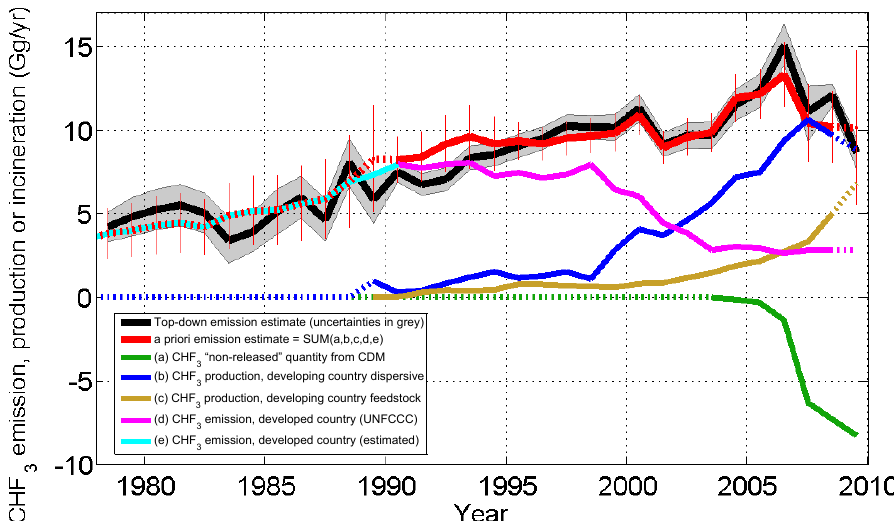
Fig. 5. Global HFC-23 (CHF 3 ) emissions from a “top-down” method (black line, 68% uncertainties shaded gray), which are based on inversion of atmospheric observations using the 2-D 12-box model, compared to the a priori emission estimate (red line, both dotted and solid, with ± 1- σ uncertainties). The a priori represents the sum of the contributions from developed and developing countries, as compiled from data submitted to the United Nations Framework Convention on Climate Change (UNFCCC) and the Clean Development Mechanism (CDM), and calculated from HCFC-22 (CHClF 2 ) production data from the United Nations Environment Programme (UNEP) and the Alternative Fluorocarbons Environmental Acceptability Study (AFEAS). A segment of the a priori (1990-2008, solid red line) is of sufficient certainty to be useful as a “bottom-up” emission estimate in a comparison to the top-down history. The observed agreement suggests a level of credibility to the UNEP HCFC-22 production data, the HFC-23 emissions reported to the UNFCCC and the incinerated quantities of HFC-23 reported by the